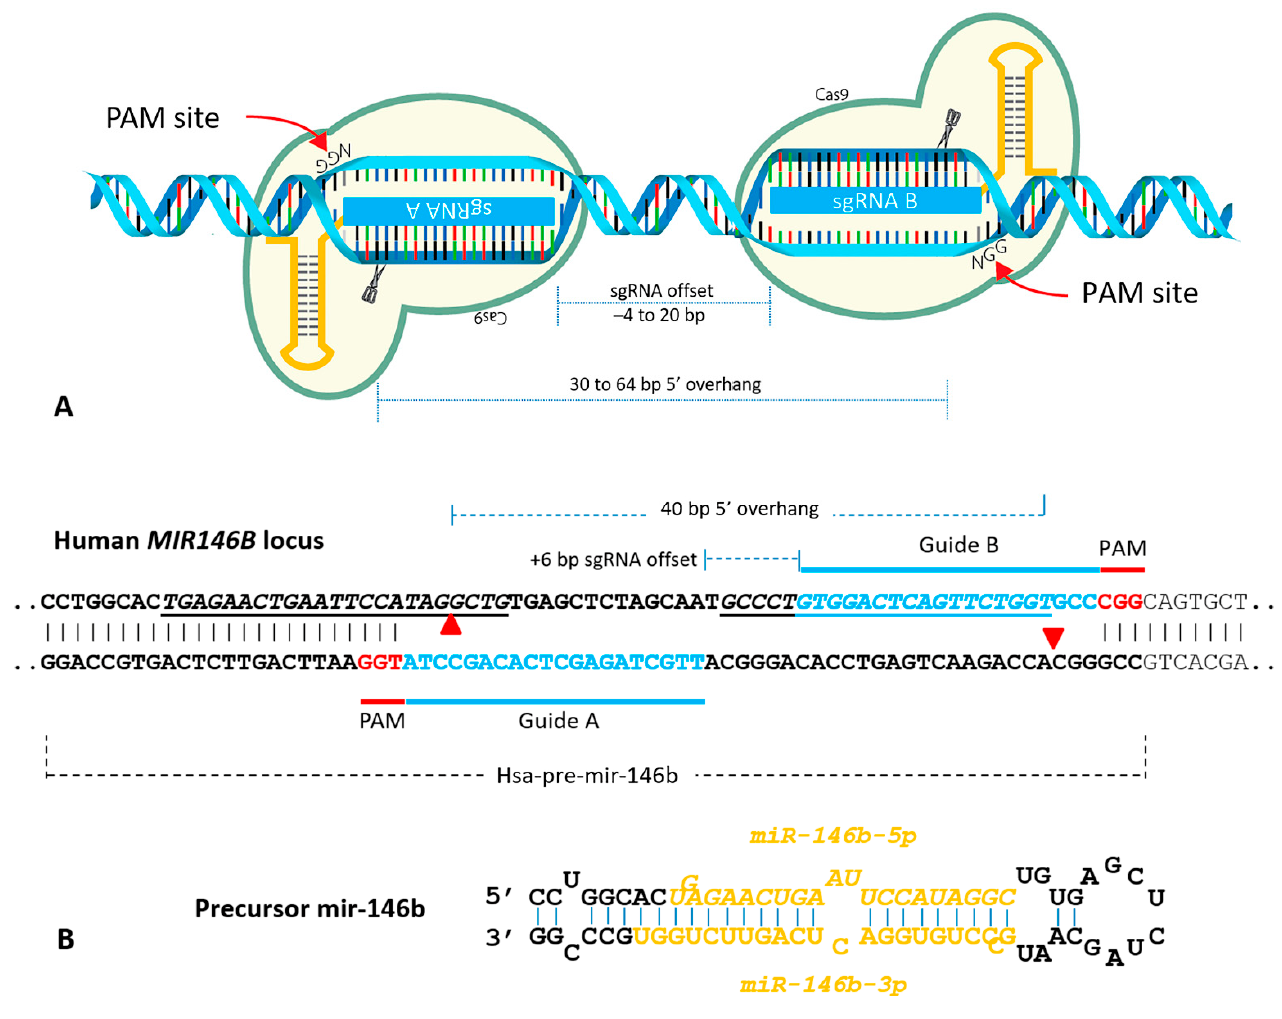
Figure 2. ( A ) Design of the PAM-out strategy to target human MIR146B with two sgRNAs in opposite strands at optimum distance. ( B ) Human MIR146B locus highlighting the precursor miR-146b sequence, and the mature strands miR-146b - 5p and 3p are underlined. SgRNA A and B target sequences are shown in blue and the PAM sequences in red. Single-strand DNA break point due to Cas9n (D10A) nickase activity is indicated by red triangle. Figure ( A ) was modified from idtdna.com to include miR-146b sgRNA design.